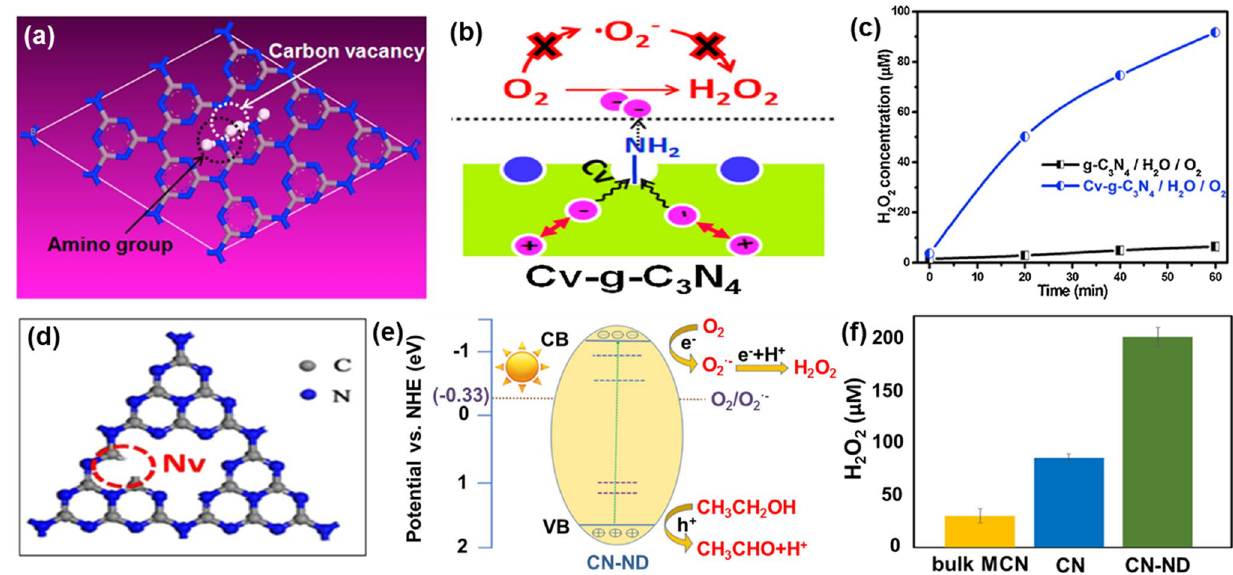
Fig. 3 a Schematic illustration of g-C 3 N 4 with carbon vacancy. b Mechanism diagram of H 2 O 2 production in Cv-g-C 3 N 4 . c Concentration of generated H 2 O 2 in g-C 3 N 4 and Cv-g-C 3 N 4 systems. Reproduced with permission from Ref. [71]. Copyright 2016 Elsevier. d Schematic illustra- tion of g-C 3 N 4 with nitrogen vacancies (CN-ND). e Proposed mechanism for H 2 O 2 generation of CN-ND. f H 2 O 2 production of different cata- lysts. Reproduced with permission from Ref. [86]. Copyright 2021 American Chemical